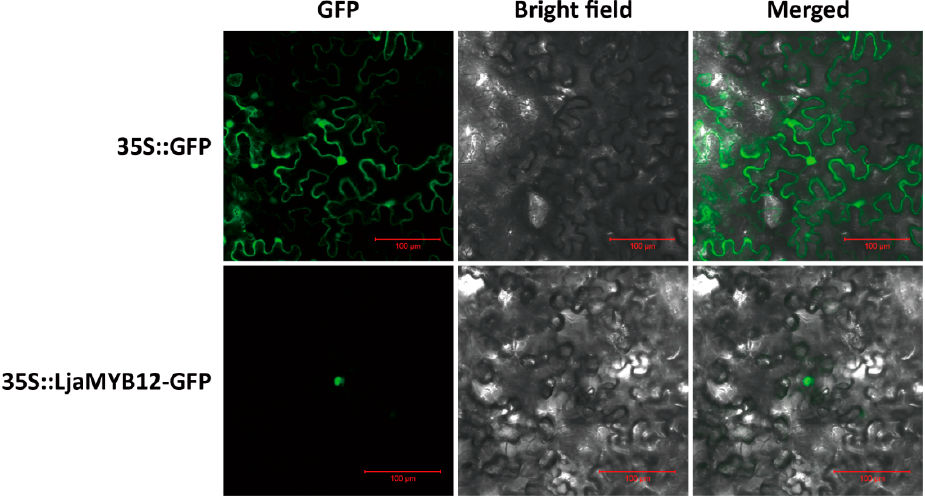
Figure 3. Subcellular localization of the LjaMYB12 protein in tobacco epidermal cells.